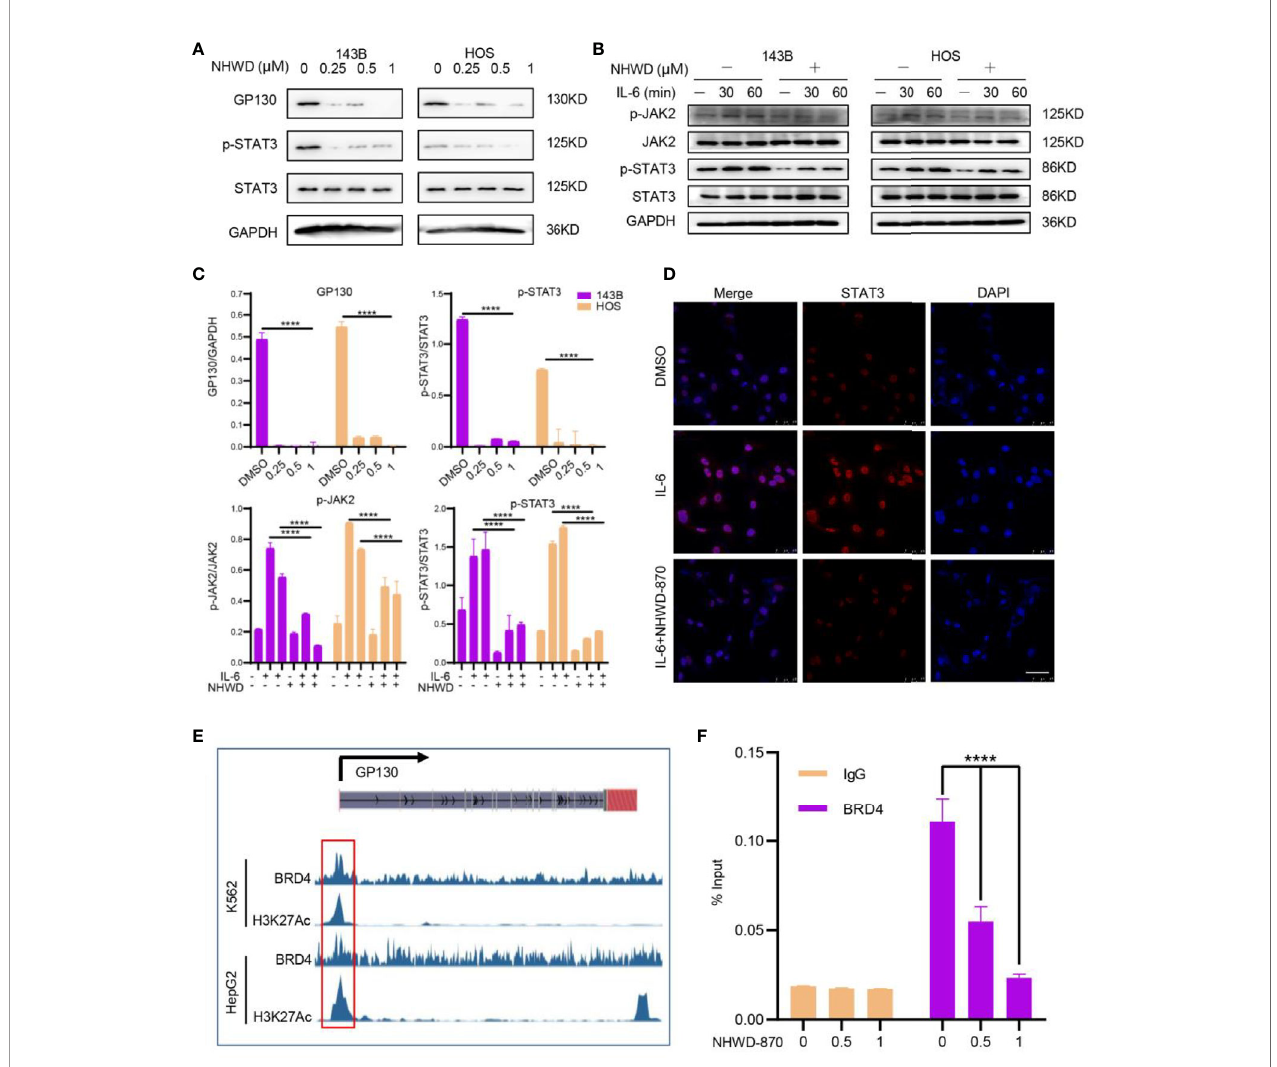
FIGURE 3 | BRD4 regulates the activation of the JAK/STAT3 signaling pathway through GP130 receptor. (A) NHWD-870 directly inhibits the phosphorylation of STAT3 at tyrosine 705 in HOS and 143B osteosarcoma cell lines. (B) Under IL-6 stimulation, the STAT3 signaling pathway was signi fi cantly activated, and NHWD- 870 effectively inhibited IL-6-induced STAT3 phosphorylation activation. (C) The expression levels of p-JAK and p-STAT3 were quanti fi ed using ImageJ software. (****P < 0.0001). (D) The nuclear translocation of STAT3 in 143B cells was determined using immuno fl uorescence. Scale bar = 50 m m. (E) The gene track for H3K27 acetylation and BRD4 in HepG2 and k562 cells from ENCODE. (F) ChIP-PCR for BRD4 association with the TSS of GP130 in 143B osteosarcoma cells treated with 1 µM NHWD-870 or DMSO using anti-BRD4 or anti-IgG as negative control. Data are expressed as the fold enrichment normalized to the input. (****P <